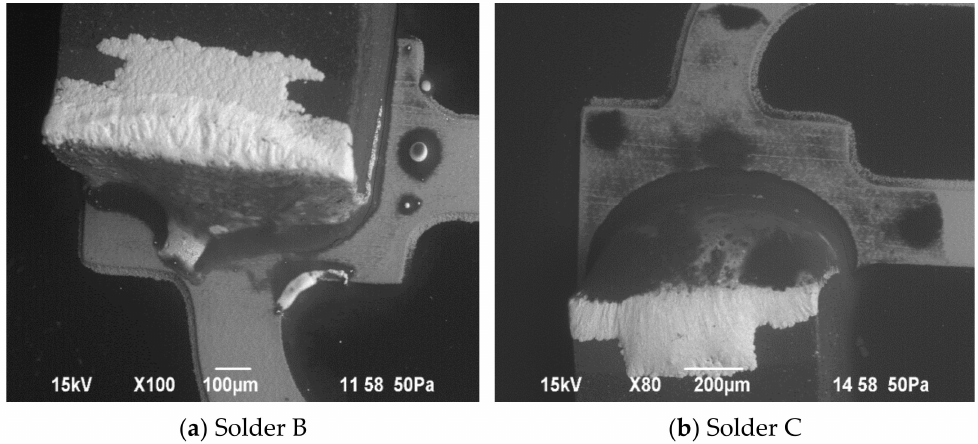
Figure 13. SEM pictures of failed soldered SMDs after bending